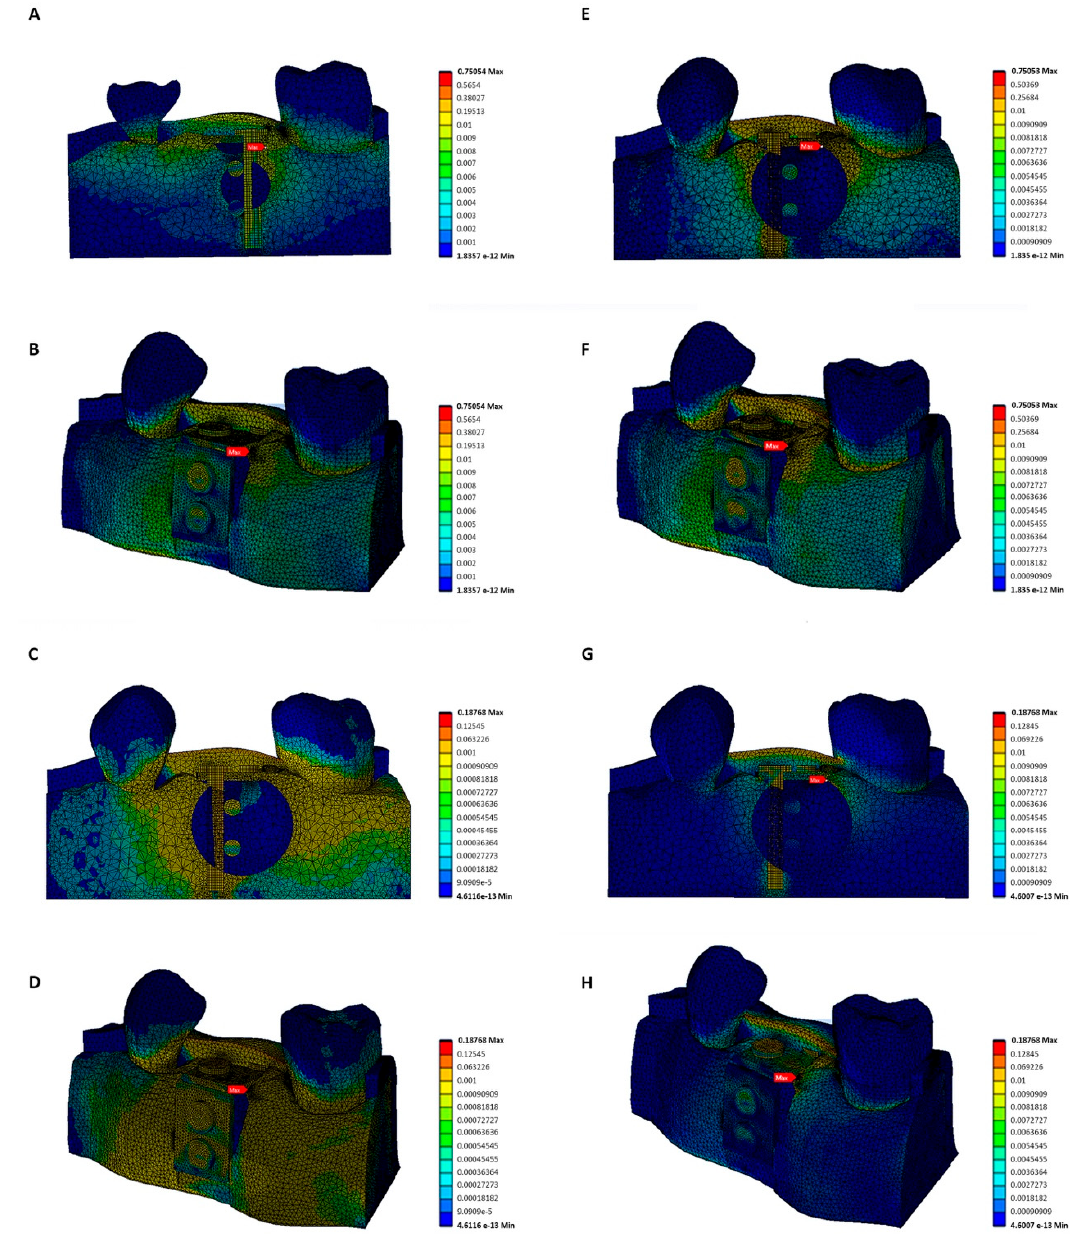
Figure 5. Stress distribution map for the different stresses and morphologies. ( A , B ) von Mises stress map for right angle 0.2 N; ( C , D ) von Mises stress map for right angle 0.05 N; ( E , F ) von Mises stress map for rounded angle 0.2 N; ( G , H ) von Mises stress map for rounded angle 0.05 N. The red arrow indicates the area of greatest transferred stress (MPa) according to the Von Mises criterion.